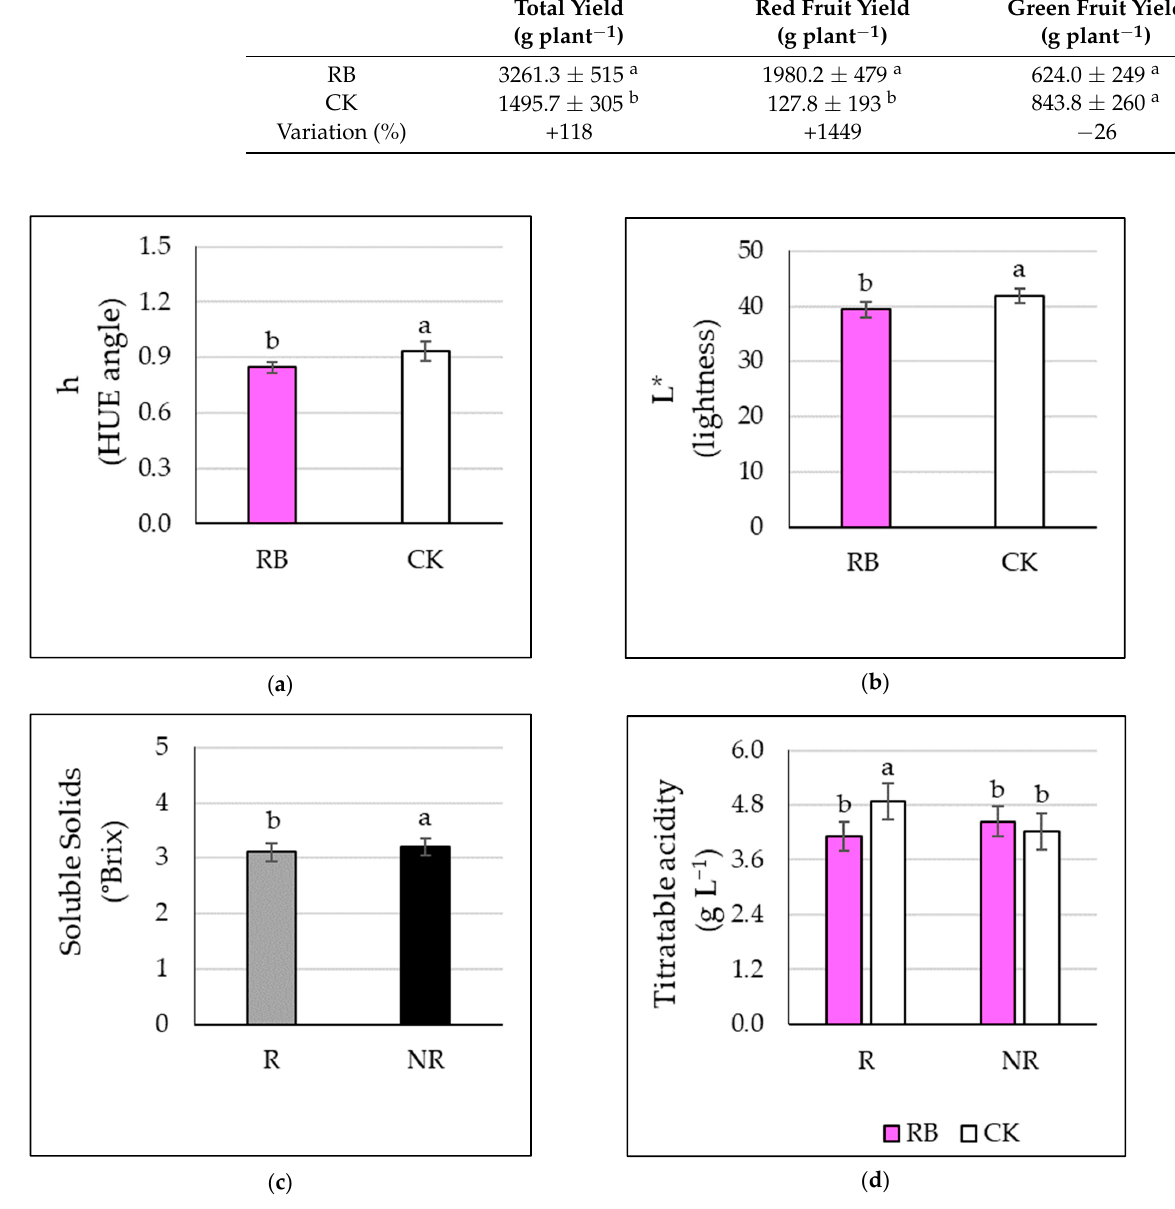
Figure 3. Effect of light (supplemental red and blue LED light, RB, and natural light only, CK) and defoliation (leaves early removal, R, and no-removal, NR) on ( a ) HUE angle, ( b ) lightness, ( c ) soluble solids and ( d ) acidity of tomato. Different letters indicate significant differences at ANOVA (significant level p ≤ 0.05). Vertical bars represent standard errors.